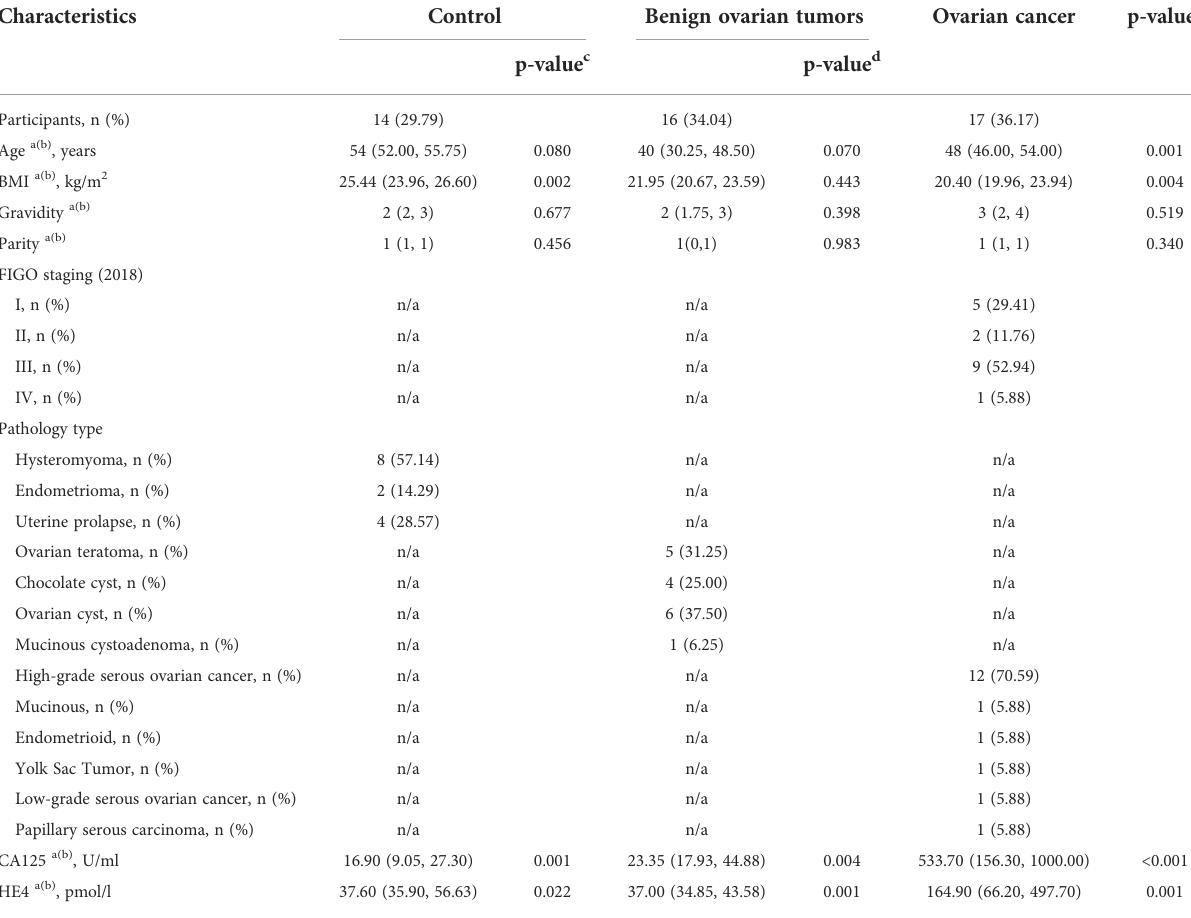
TABLE 1 Clinical characteristics of study